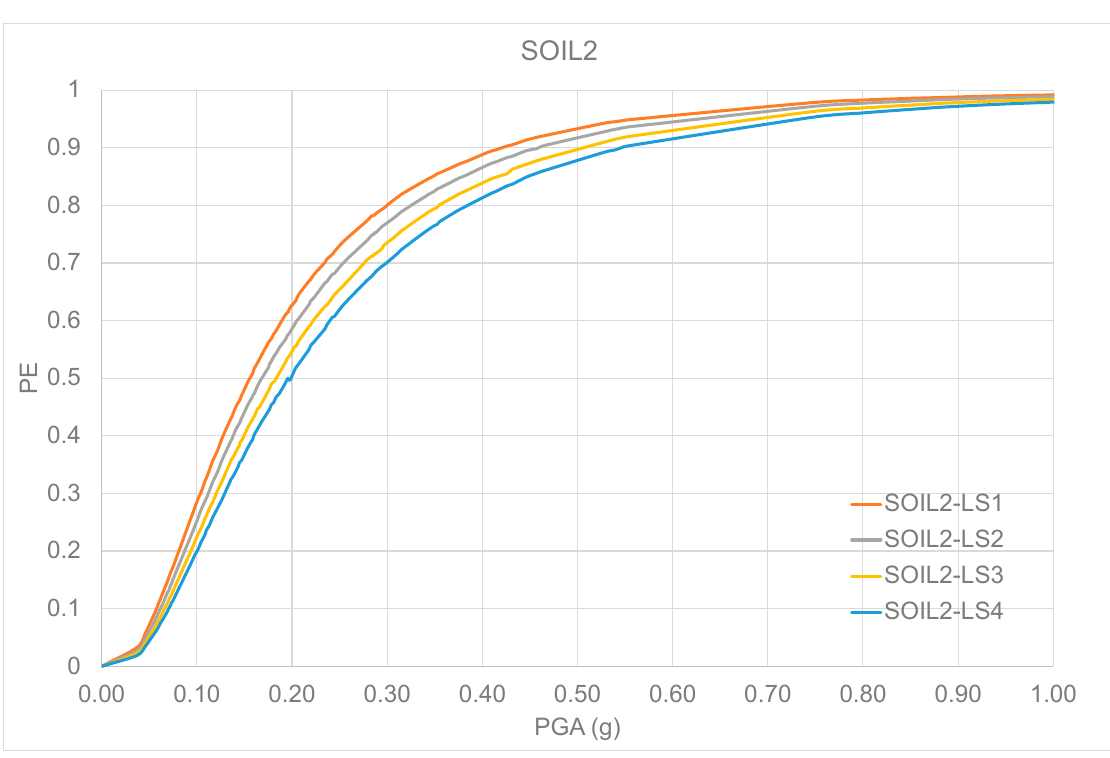
Figure 8. Fragility Curves: SOIL2.